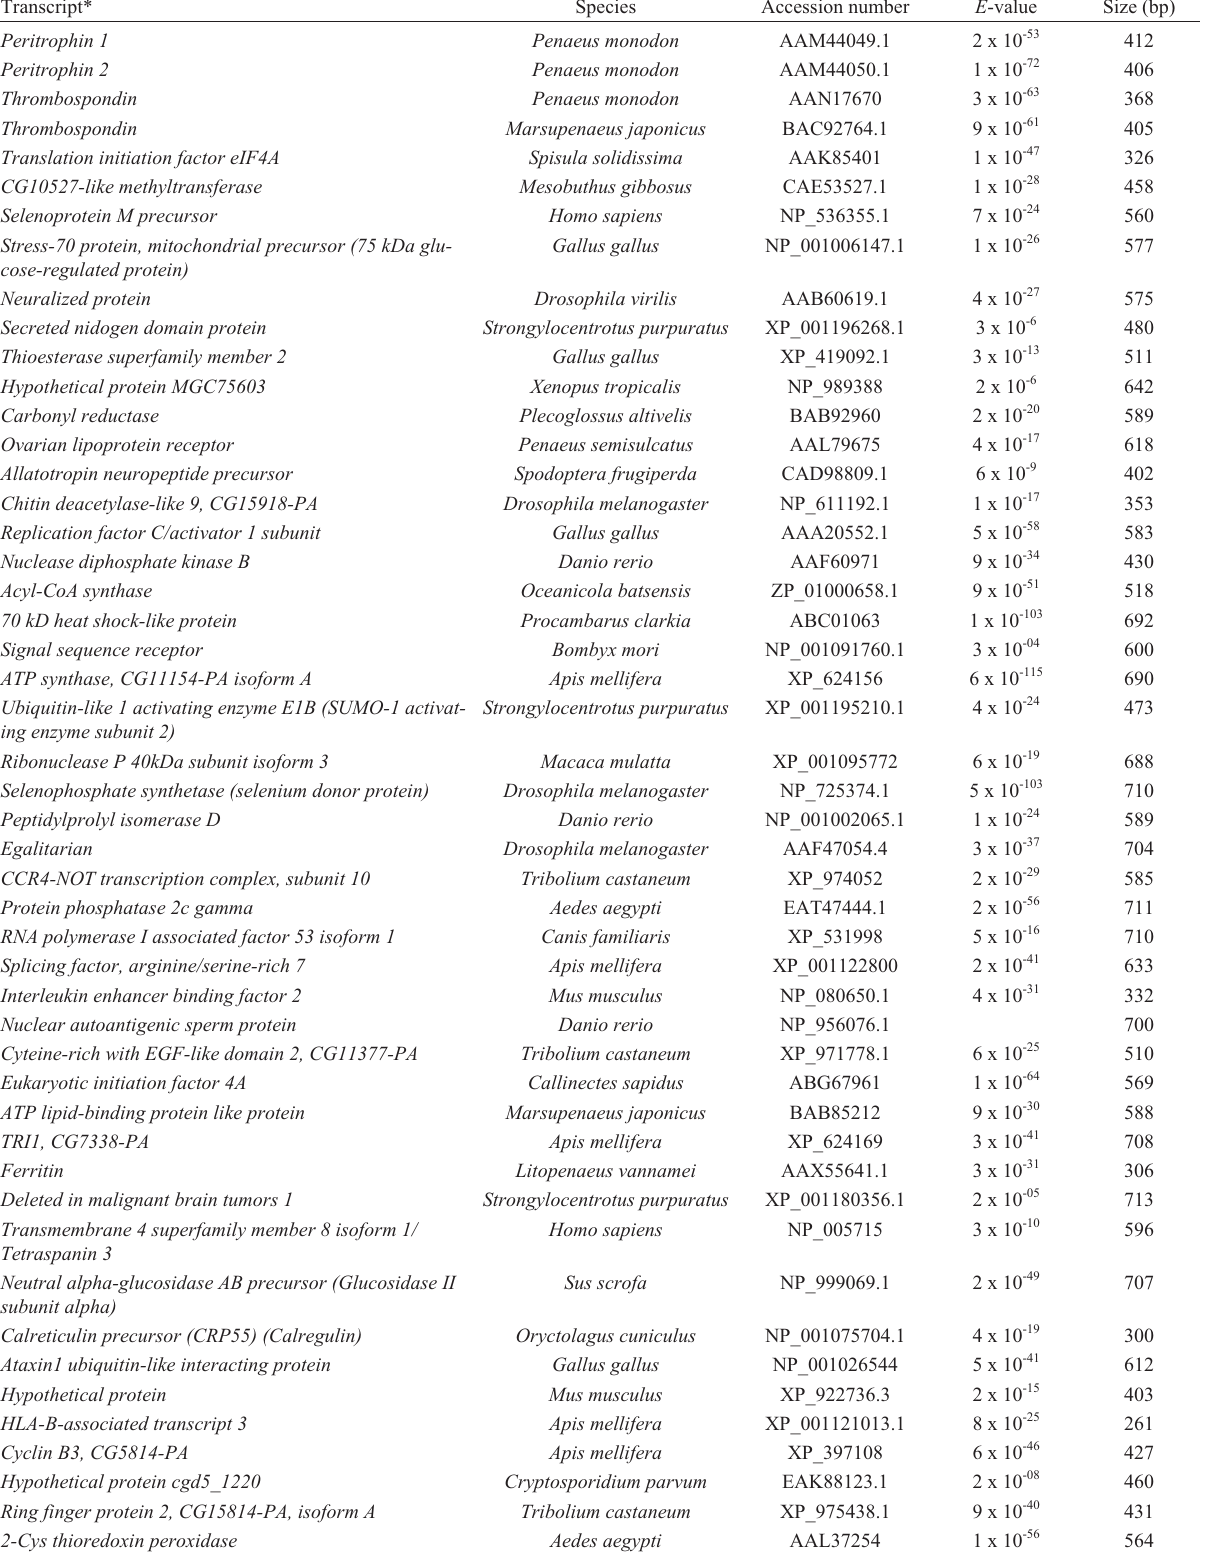
Table 3 - Examples of known transcripts excluding ribosomal proteins found in the reverse ovarian SSH library (cDNAs from stage I ovaries as the tester and those from stage III ovaries as the driver) of P.